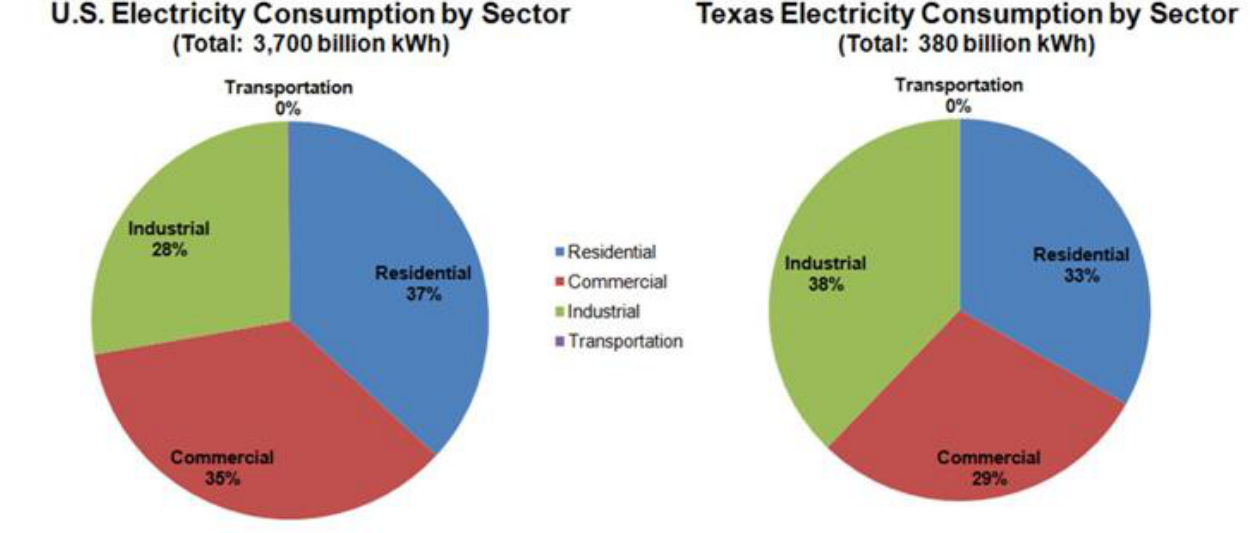
Fig. 1 . United States (left) and Texas (right) electricity consumption, in percent, by sector for 2006 (Energy Information Administration 2008, Energy Information Administration 2009b). Texas uses a larger percentage of electricity for industrial purposes than does the United States as a whole. (kWh: